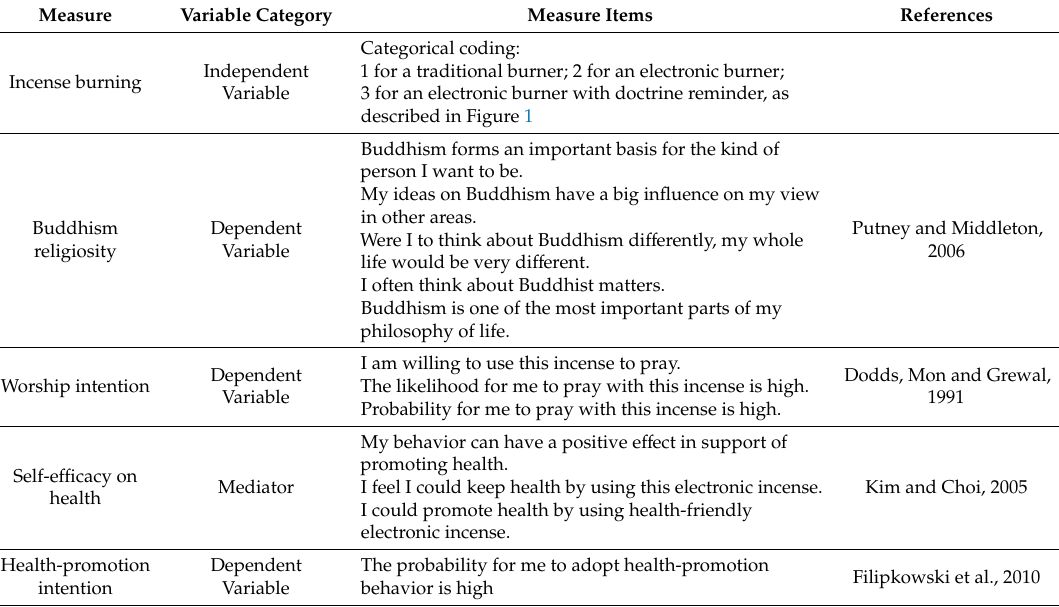
Table 1. Description of di ff erent variables and their